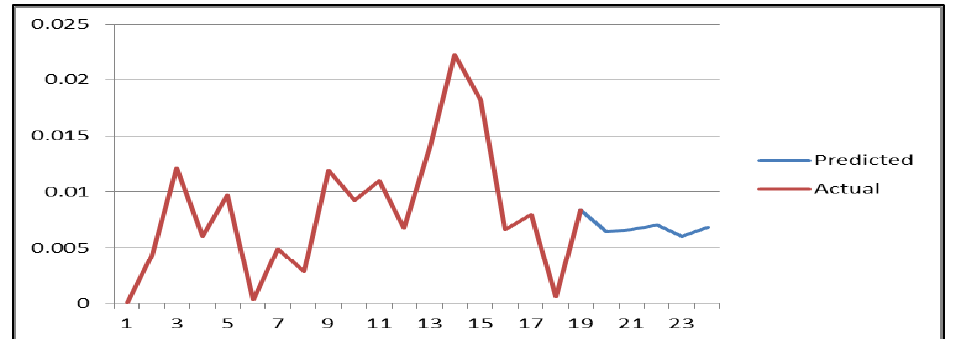
Figure.12. Short-term Prediction of Linear Combination of GARCH and NNAR